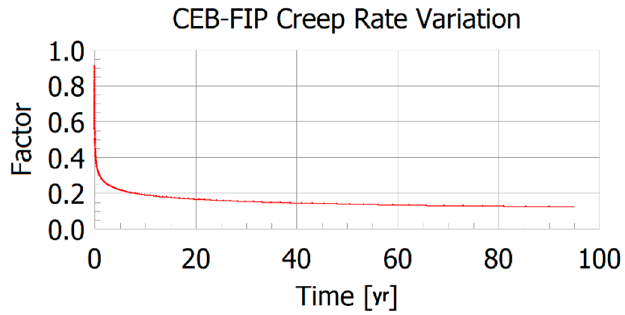
Figure 5. Creep factor versus time plot.